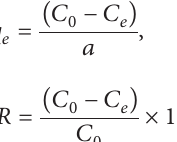
Figure 1: XRD spectra of (a) red mud and (b) fly ash.